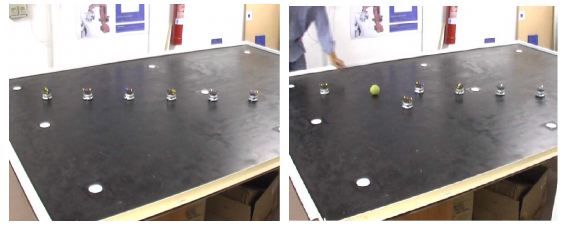
Figure 6. Two snapshots of a formation control mission with a moving obstacle passing through the